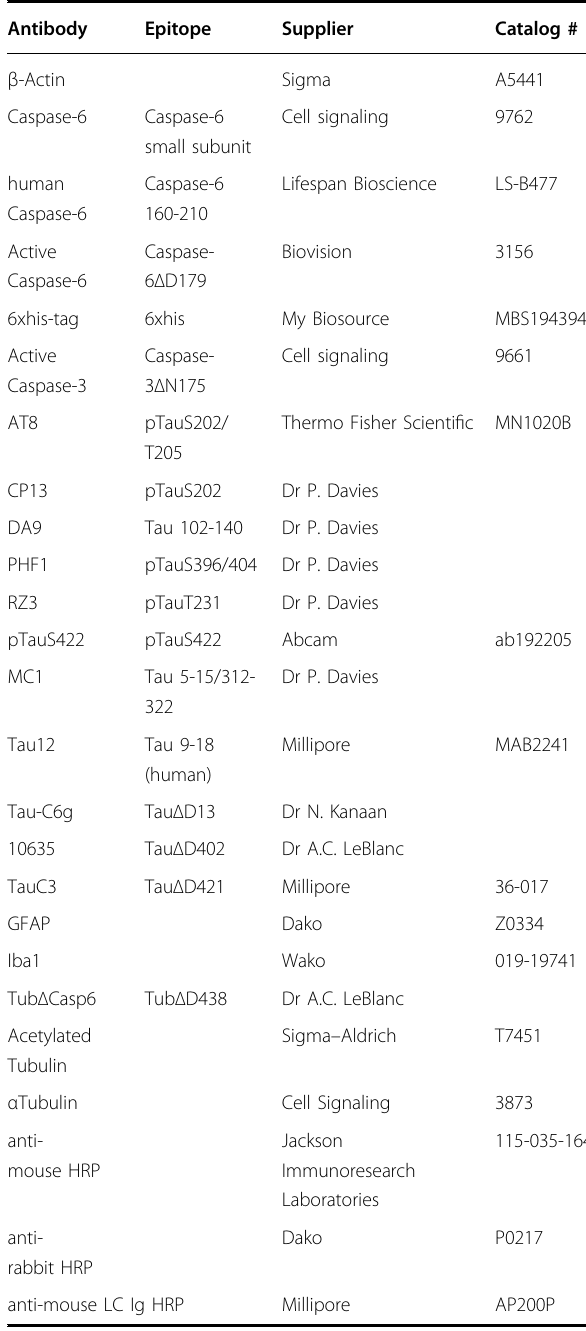
Table 1 Antibodies used in this